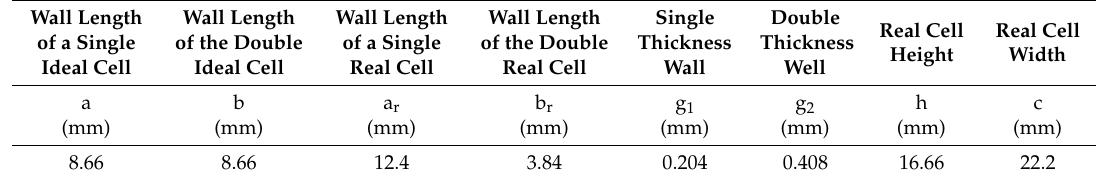
Figure 6. Perfect shape cell of the honeycomb core ( a ), modified shape cell (close to real shape) of the honeycomb core ( b ). Table 1. Ideal and real cell parameters.